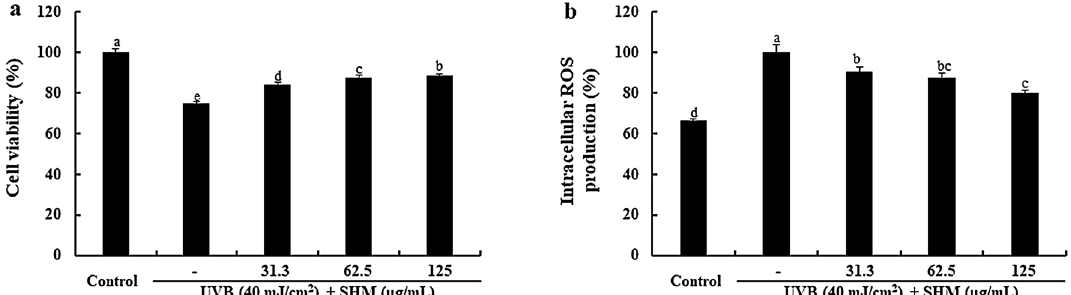
Figure 1. Cytoprotective effect of SHM on cell viability ( a ) and intracellular ROS production ( b ) in UVB- exposed human keratinocytes. Values are expressed as means ± SE of triplicate determinants (n = 3). a–e The bars with different letters represent significant differences (p < 0.01).